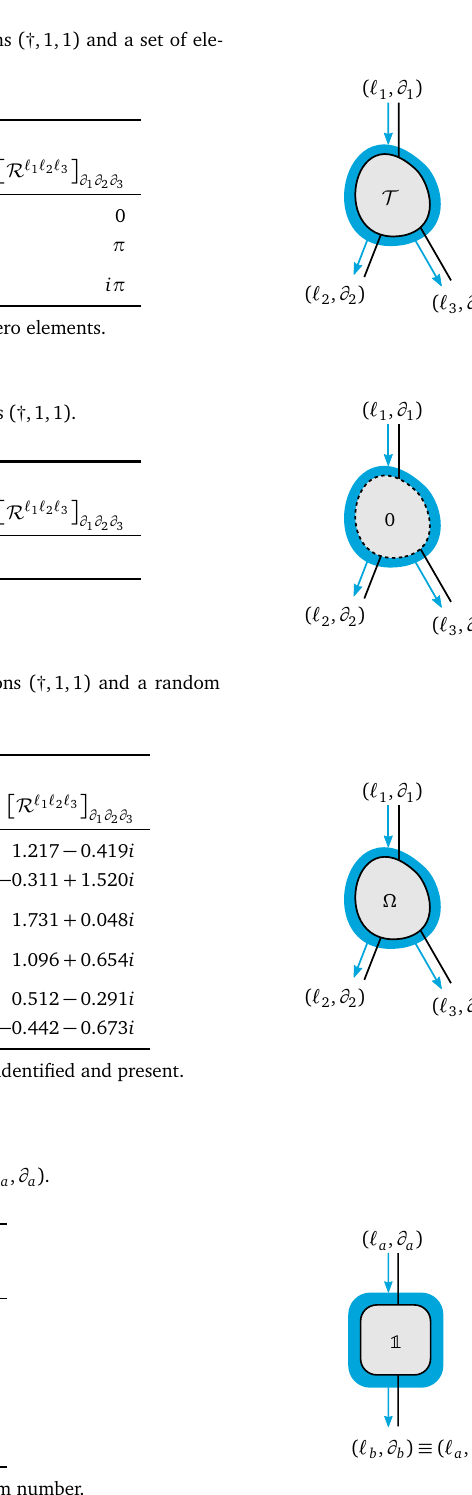
Figure 17: Symmetric tensor initialization examples for tensors with the same G = Z symmetry and links ( (cid:96) elements, (B) filled with zeros, (C) from random elements, e.g. a Gaussian distribution, (D) an “identity matrix” on a given link ( (cid:96)